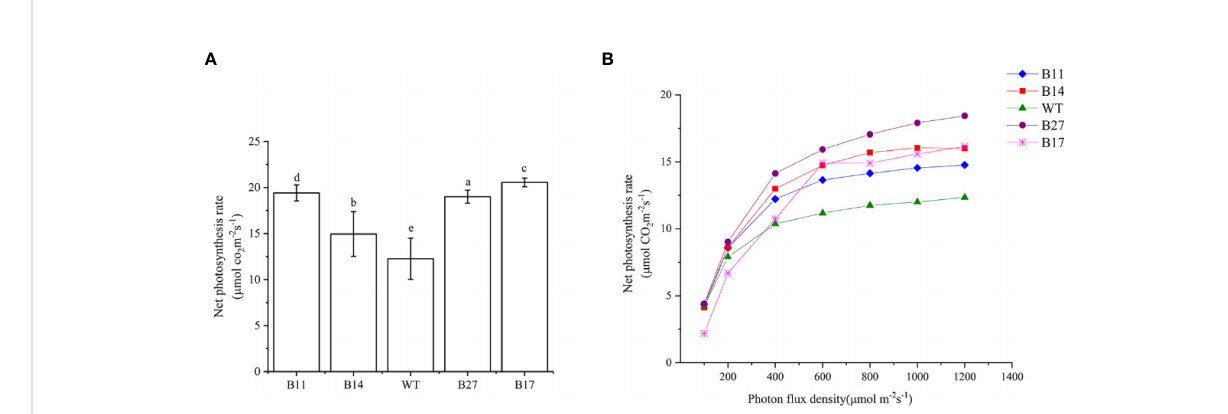
FIGURE 4 Net photosynthetic rate of the transgenic plants and light response curves of transgenics produced by asexual propagation for two generations. (A) Net photosynthetic rate of the transgenic plants. At 700 m mol m -2 s -1 light intensity, temperature 30°C, normal atmospheric conditions (CO 2 concentration of approximately 400 m mol) was determined. Data are means ± SE of 30 biological replicates. Different letters indicate statistically signi fi cant differences between genotypes as determined by ANOVA using Tukey-Kramer posthoc test (P < 0.05). (B) Light response curves of transgenics produced by asexual propagation for two generations. At a temperature of 30°C, normal atmospheric conditions (CO2 concentration of approximately 400 m mol) were used.